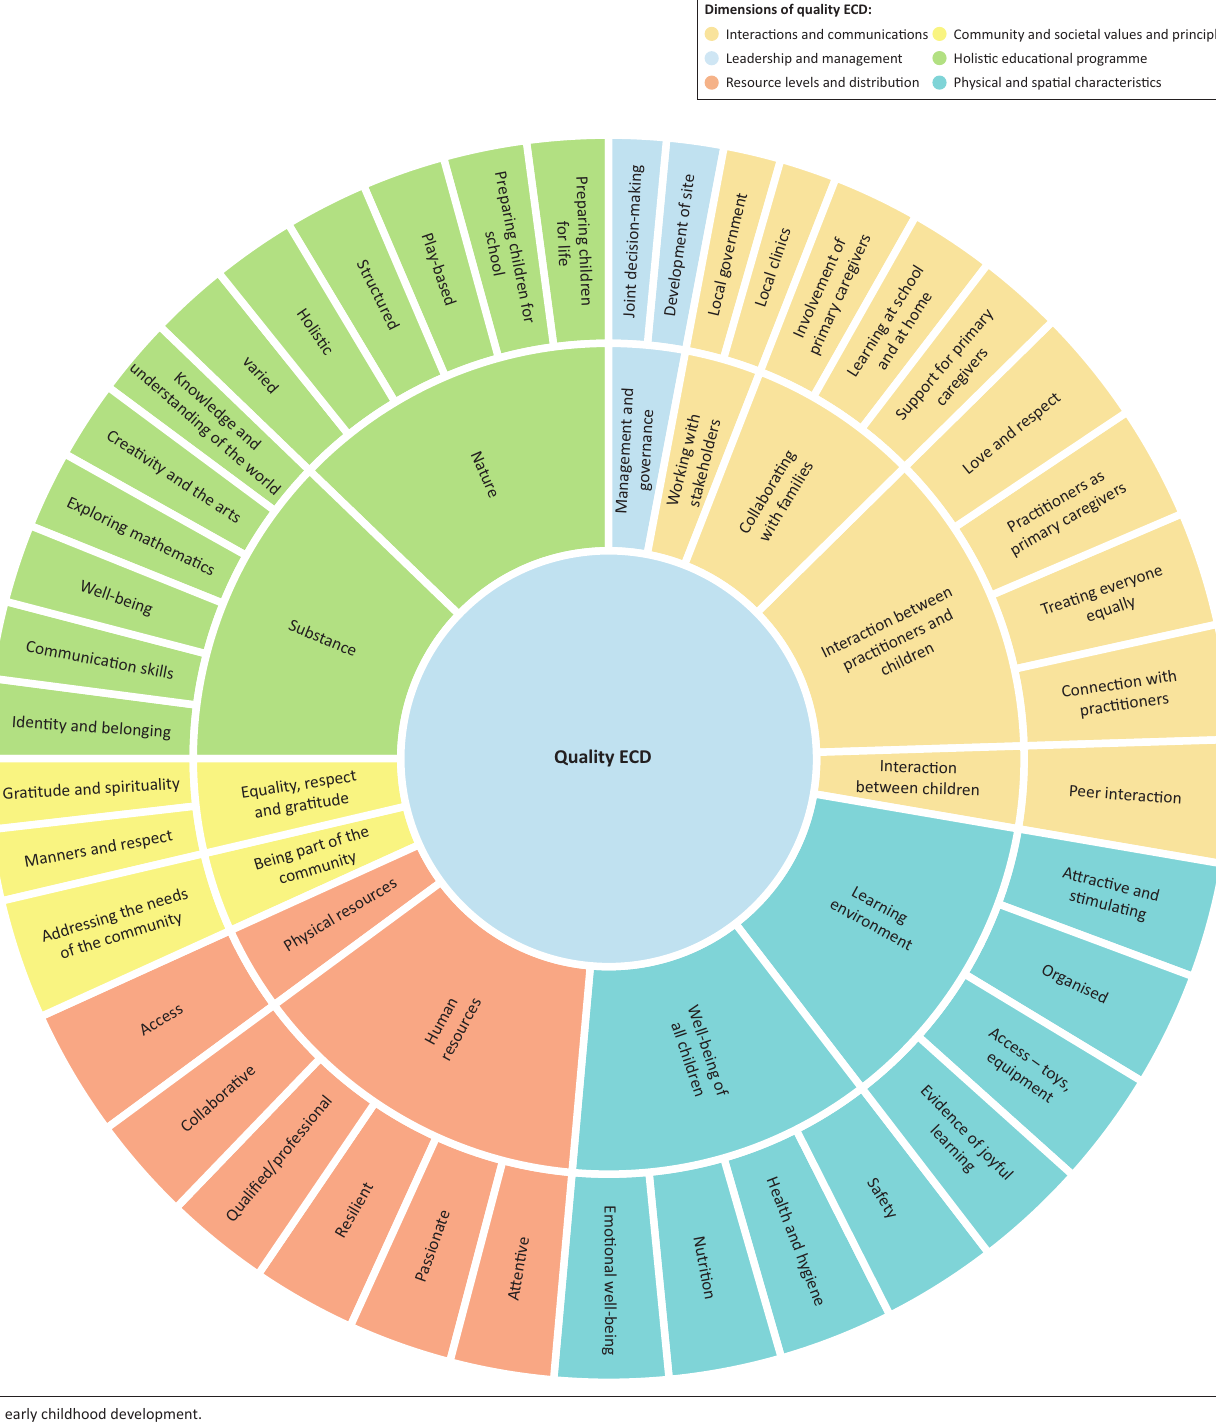
FIGURE 2: Exploring quality early childhood development: Analysis emerging from participant